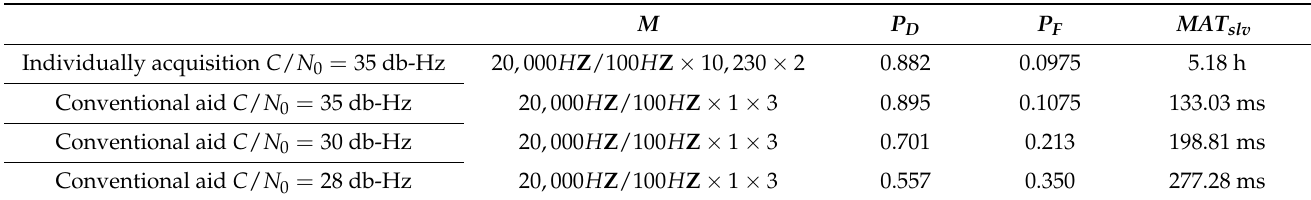
Table 2. Analysis of MAT slv for a conventional method with different C / N 0